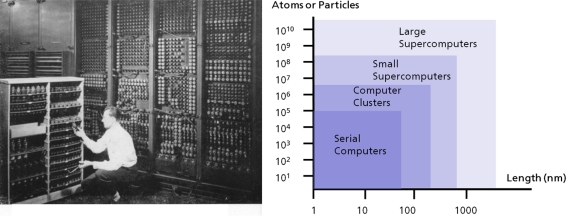
(a) The ENIAC (Electronic Numerical Integrator And Computer), one of the first electronic computers that started to operate in 1946. (The very first working electronic computer was the Z3 developed by Konrad Zuse in the 1930s in Germany). The ENIAC weight 30 tons used more than 18.000 vacuum tubes that can be seen in the picture and had a basic clock speed of 105 cycles per second. It was programmed by plugging cables and wires and setting switches using a huge plugboard that was distributed over the entire machine. US Army Photo. (b) Illustration of the available system size (edge length of a simulated cube of classical particles or atoms) and the necessary computer hardware for modern large-scale MD.